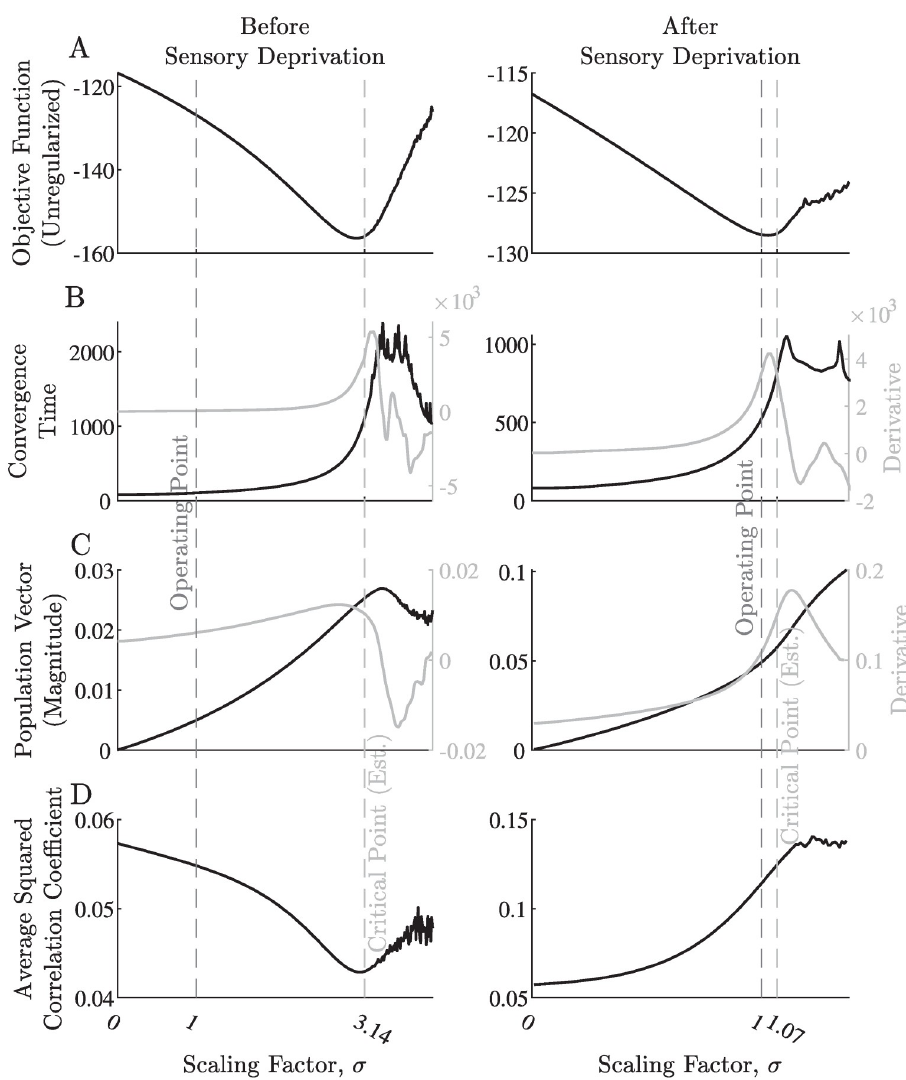
Fig 5. Global measures for different scaling of the recurrent connections. A: The network’s objective function, without the regularization terms. Low values of the objective function correspond to high network’s susceptibility. B: The convergence time of the network dynamics using Euler’s method; i.e., the number of time-steps until the simulation reaches a convergence criterion (see Methods). C: The population vector magnitude. D: The squared correlation coefficient between pairs of output neurons, averaged over all such pairs. All the above measures are displayed for different scaling factors of the recurrent connectivity matrix K tr , as found by the training process; i.e., for each value of the scaling factor σ , the different measures were evaluated by replacing the recurrent connectivity matrix with K = σK tr . In the left panels, we used the recurrent connectivity matrix K tr trained on typical stimuli, while in the right panels, we used the recurrent connectivity matrix obtained after sensory deprivation. The operating point is at a scaling factor of 1, namely, the recurrent connectivity the learning process has converged to. The marked critical point ( � 3.14 in the left panels and � 1.07 in the right panels) is the scaling factor for which the spectral radius ρ ( K ) of the recurrent connectivity matrix is 4, i.e., 4/ ρ ( K tr ). The derivatives of B–C are also displayed for better visualization of transitions in values. The exact values of the objective function and convergence time displayed in A–B are completely arbitrary, therefore these figures should only be considered in a qualitative manner. The attenuation profile’s parameters were k 0 = 20, β = 10 (see Fig 2B). For visualization purposes, different panels are displayed on different vertical